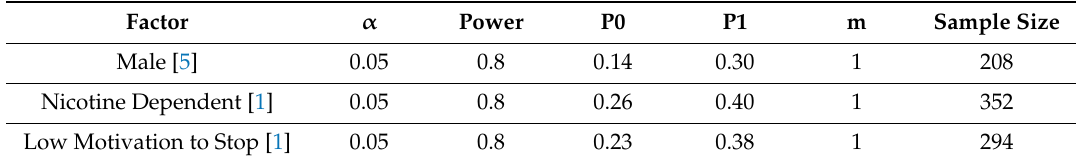
Table 2. Sample size calculation for the objective of determining factors associated with positive smoker identity. Factor α Power P0 P1 m Sample Size Male [5] 0.05 0.8